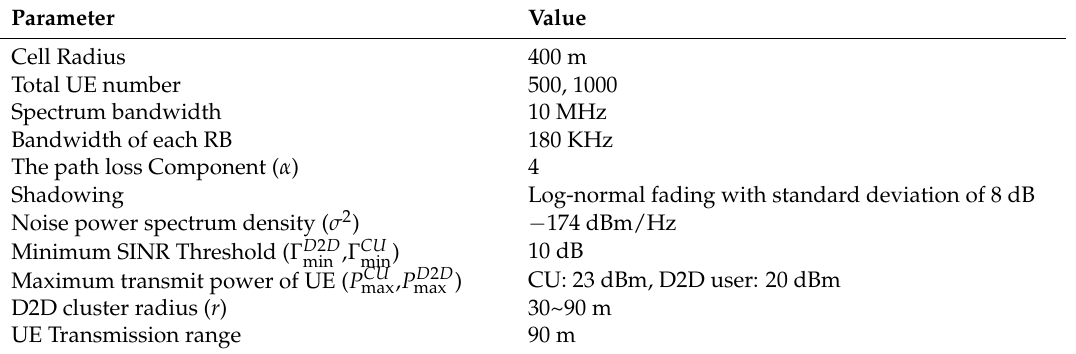
Table 1. The simulation parameters. UE: user equipment; RB: resource blocks; SINR: signal-to-